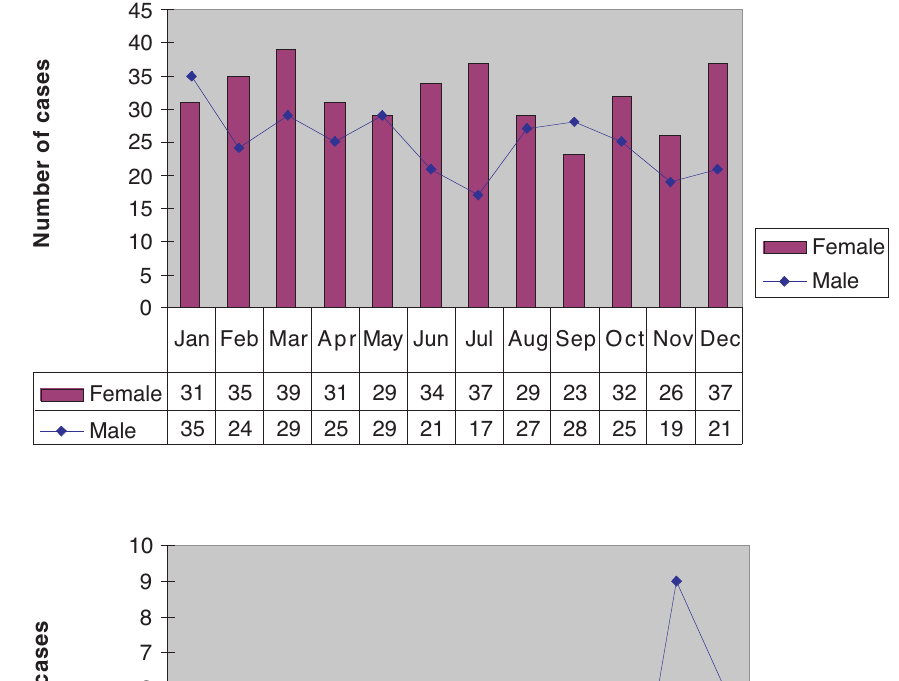
Feb Mar Apr May Jun Jul Aug Sep Oct Nov Dec